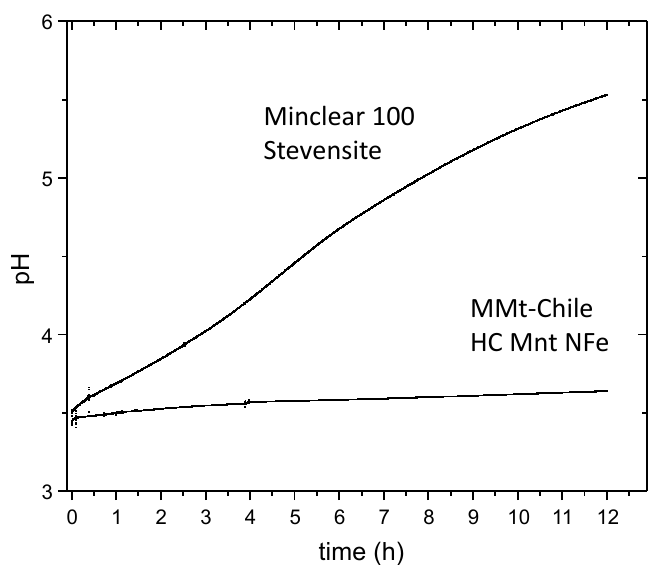
Figure 3. Evolution of pH as a function of time in clay mineral suspensions (1 g / 40 cm 3 ) in 0.1 M NaCl, 0.5 g / L TC after adjusting the pH to a stable value of 3.5. The pH data were recorded every 10 s for 12 h, under continuous stirring. HC Mnt NFe: High-charge, low Iron content Mnt.